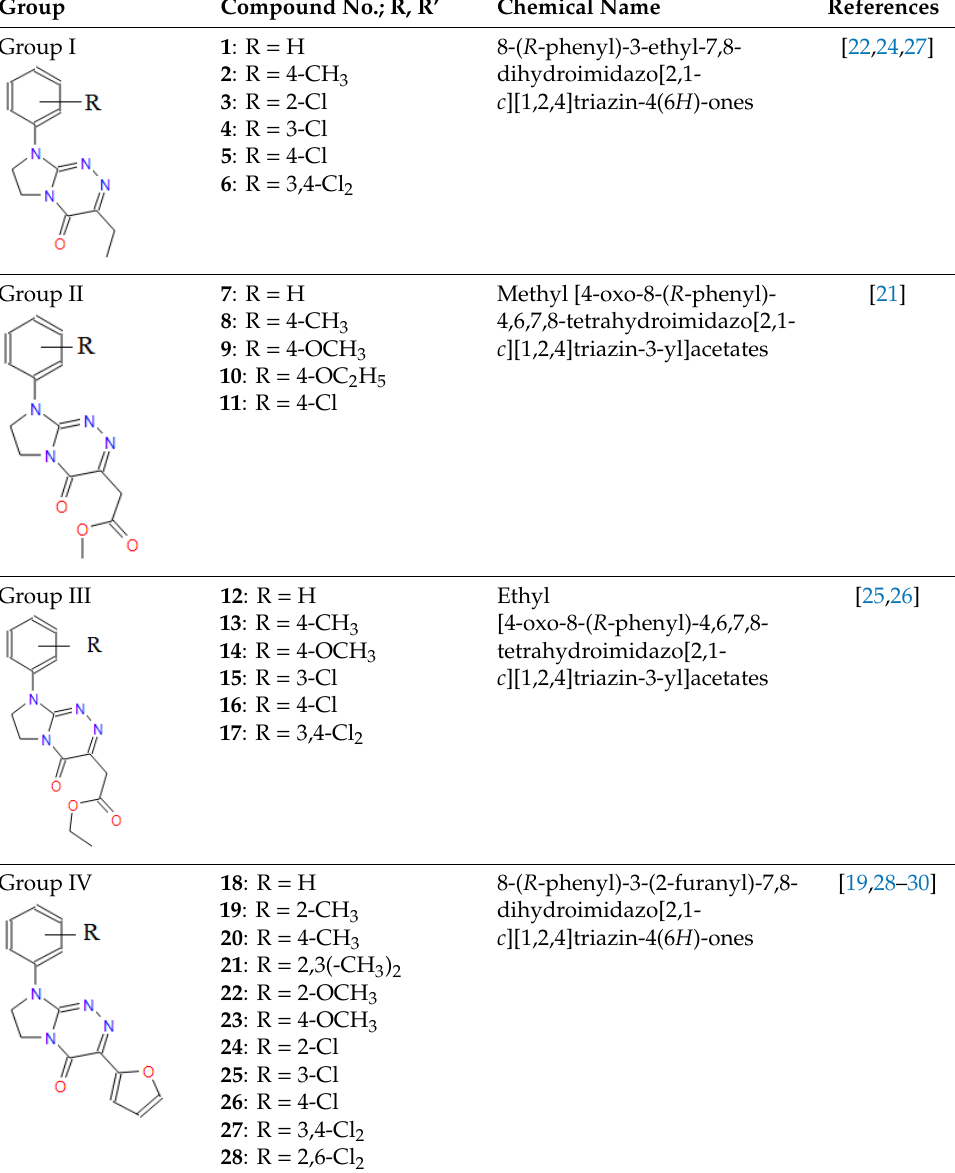
Table 1. Compounds tested.